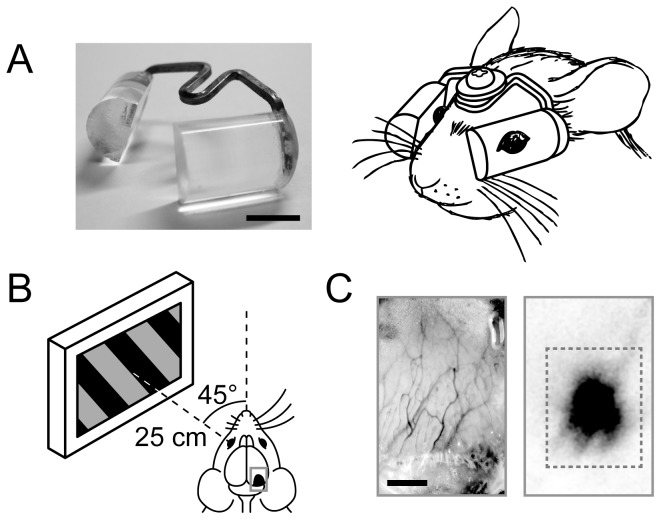
Orientation-restricting goggles and experimental setup for intrinsic signal optical imaging.(A) Photograph of goggles (left) and picture of a goggle-mounted mouse (right). The scale bar indicates 5 mm. (B) The monitor screen presenting visual stimuli was placed 25 cm apart from either eye of a mouse. The angle between the center of the screen and the animal's midline was set at 45°. Optical imaging was performed transcranially in a rectangular region in the hemisphere contralateral to the stimulated eye, which included the primary visual cortex. (C) Images of blood vessels in the skull and cortical surface (left), and stimulus-evoked intrinsic signals whose strength is indicated by their darkness (right). A detailed analysis was performed using the signals evoked inside the dashed rectangle. The scale bar indicates 1 mm.